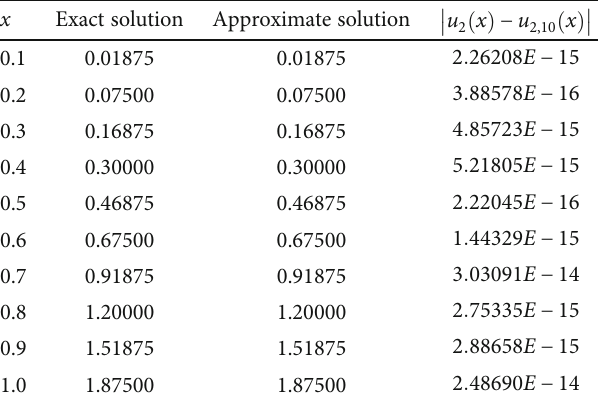
x Þ for Example 2. 2 ð